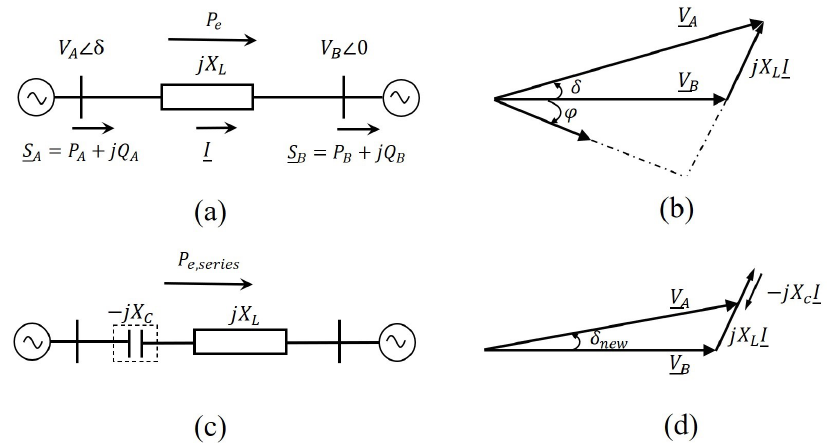
Figure 4. Change of line reactance caused by the insertion of a series capacitor: ( a ) one-line diagram, ( b ) phasor diagram, ( c ) one-line diagram with the inserted capacitor, and ( d ) phasor diagram. Based on Reference [4].